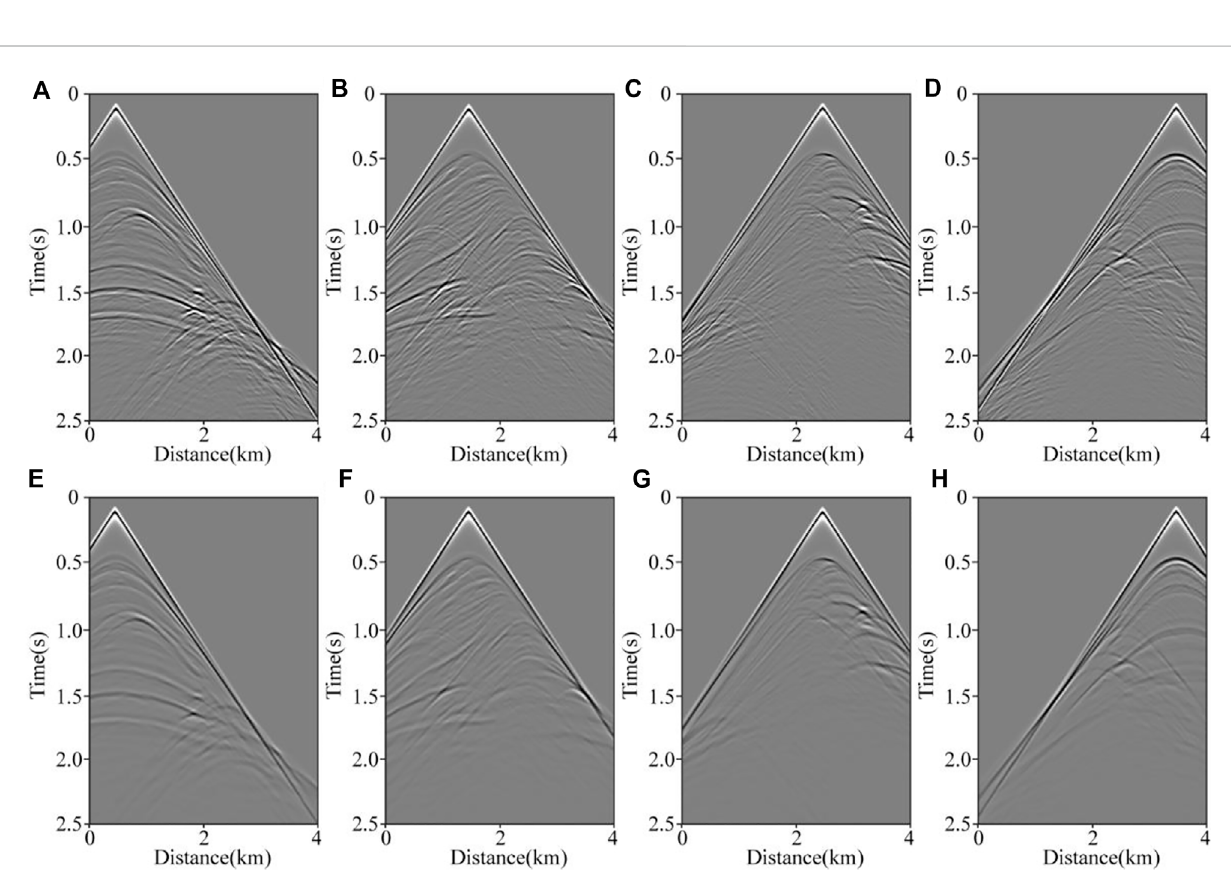
FIGURE 6 Common-gathers. The fi rst row corresponds to the elastic media and the second row correspond to the loss media. Columns 1 – 4 represent to the 10th, 30th, 50th, and 70th shots, respectively.